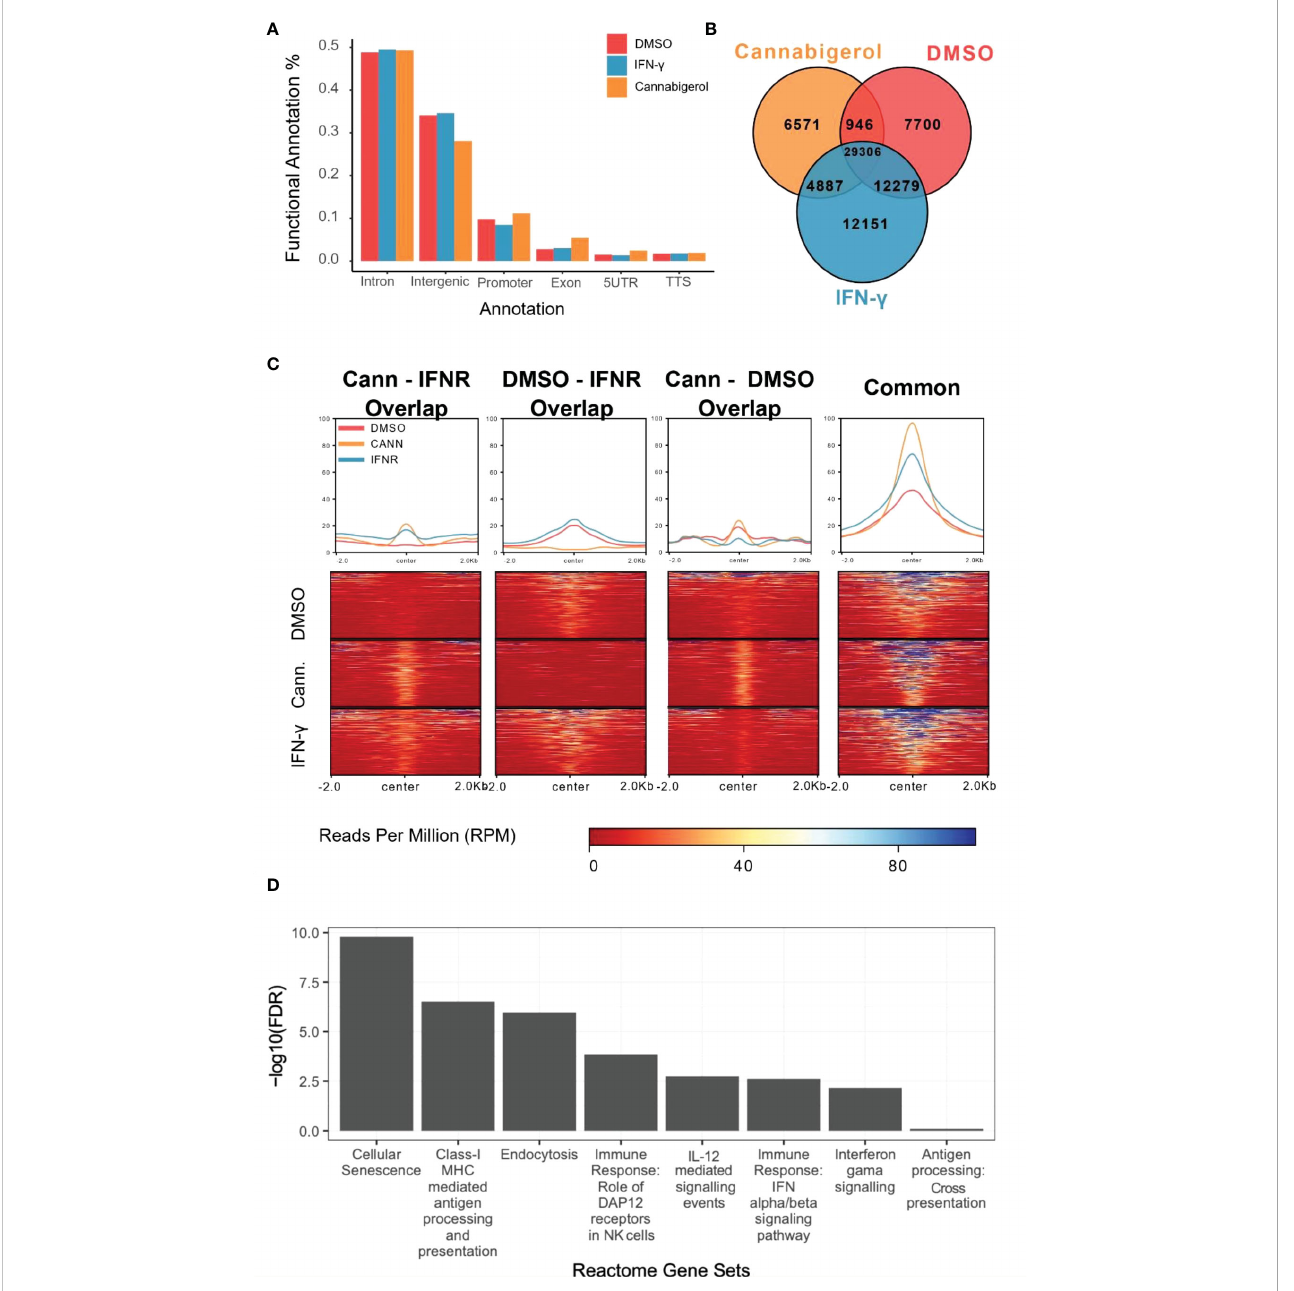
FIGURE 7 Functional annotation of H3K27ac marks induced by cannabinoids in an antigen processing de fi cient metastatic carcinoma. (A) Gene regions modi fi ed by H3K27ac. Regions were plotted. (B) H3K27ac peaks locations were compared. (C) H3K27 acetylation levels of common regions were higher than all other combinations of interactions. At common regions, cannabigerol induction demonstrates increased global acetylation similar to IFN- g . (D) Pathway analysis of closest genes with respect to overlap of Gained/Cannabigerol gene sets < 0.01 FDR were fi ltered out. Functional Annotation of H3k27ac regions showed that cannabigerol and IFN- g acetylation pro fi le enriched on intergenic/intronic parts of the genome. DMSO and IFN- g samples then annotated as DMSO only (Lost, n= 8588), DMSO-IFN- g common (Common, n=39311) and IFN- g only (Gained, n= 15886). DMSO and cannabigerol samples then annotated as DMSO only (n= 15972), DMSO-cannabigerol common (n=31927) and cannabigerol only (Gained, n=